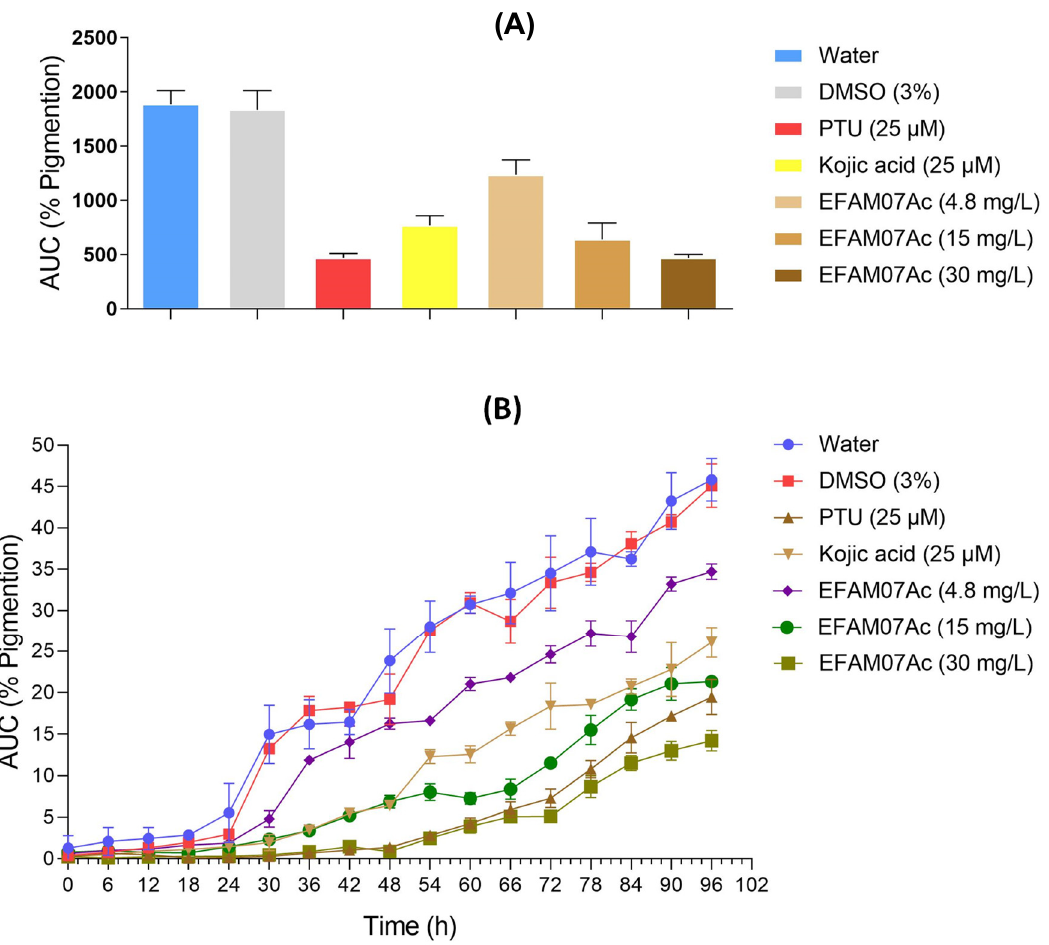
Figure 7. Effect of treatment with AM07Ac extract (4.8 mg · L − 1 , 15 mg · L − 1 , and 30 mg · L − 1 ) on melanin synthesis and tyrosinase activity in zebrafish embryos. ( A ) Percentage of melanogenesis inhibition as a function of time in different fungal extract concentrations compared with positive and negative controls. ( B ) Expresses the area under the curve (%AUC) obtained by pigments in the embryos as a function of time. Results are presented as mean ± SD (n = 50 embryos/group). Di ff erences between groups were analyzed by one-way analysis of variance (ANOVA), followed by Tukey’s test ( p < 0.05).